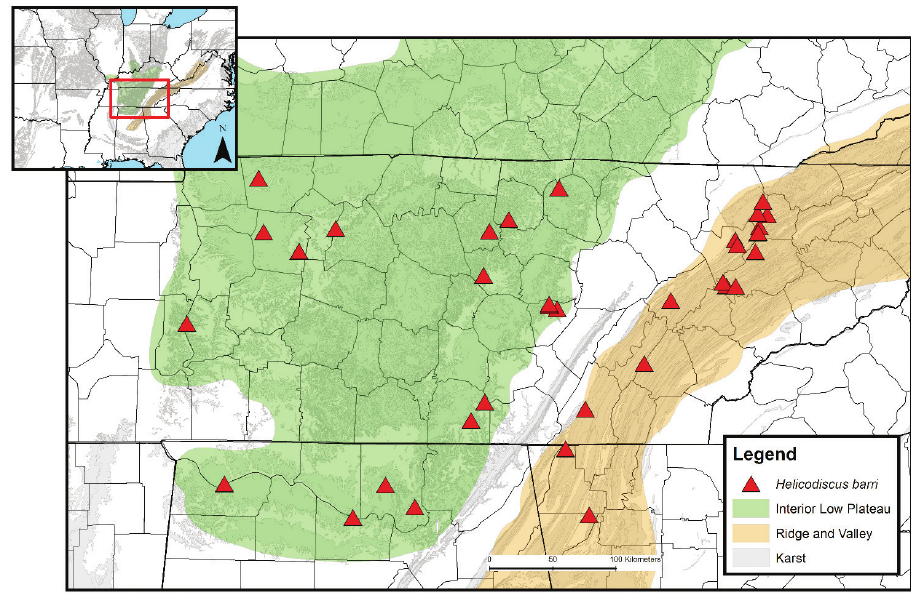
Figure 1. Geographic distribution of Helicodiscus barri from this study in relation to karst adapted from Weary and Doctor (2014). Triangles represent cave